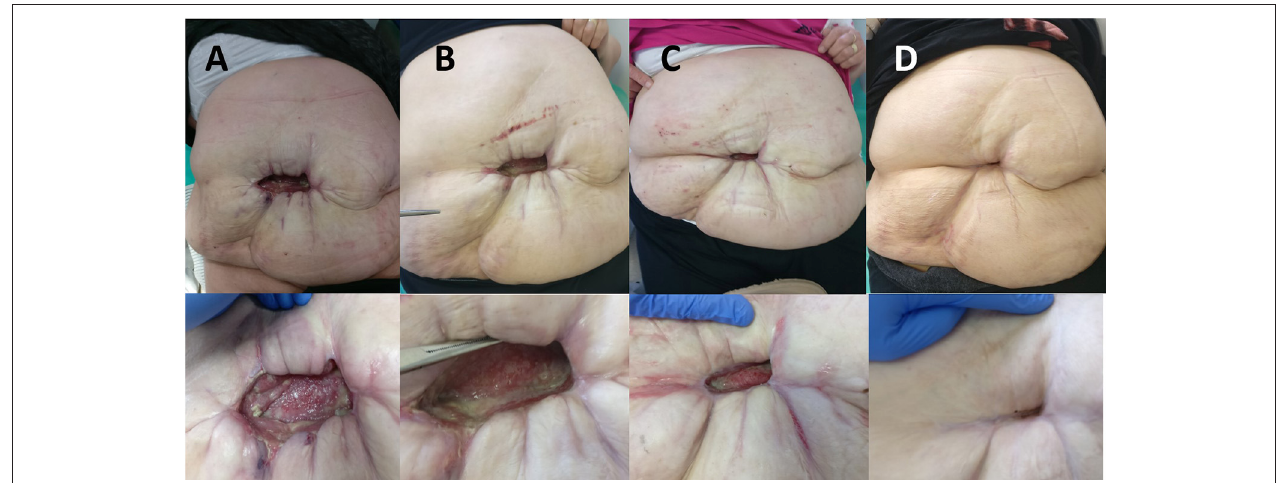
FIGURE 3 | (A) View of the abdomen 3 months after the initial surgery. (B) View of the abdomen 4 months after the initial surgery. (C) View of the abdomen 6 months after the initial surgery. (D) View of the abdomen 10 months after the initial surgery.